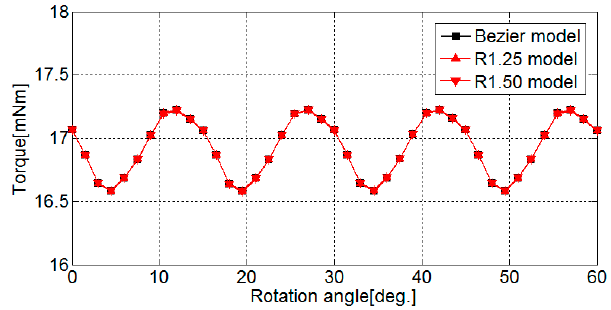
Figure 15. Comparison of torque waveforms in the Bezier model, R1.25 model, and R1.50 model.